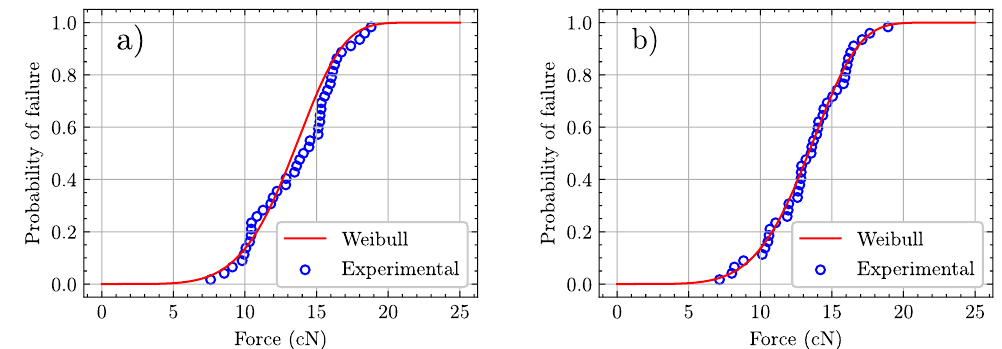
Figure 7. Cumulative failure distribution as a function of load for ( a ) untreated ( 0-CFs ) and ( b ) trated ( I-CFs ) monofilaments. Experimental data are plotted as discrete points and fitted to a Weibull distribution (red line).